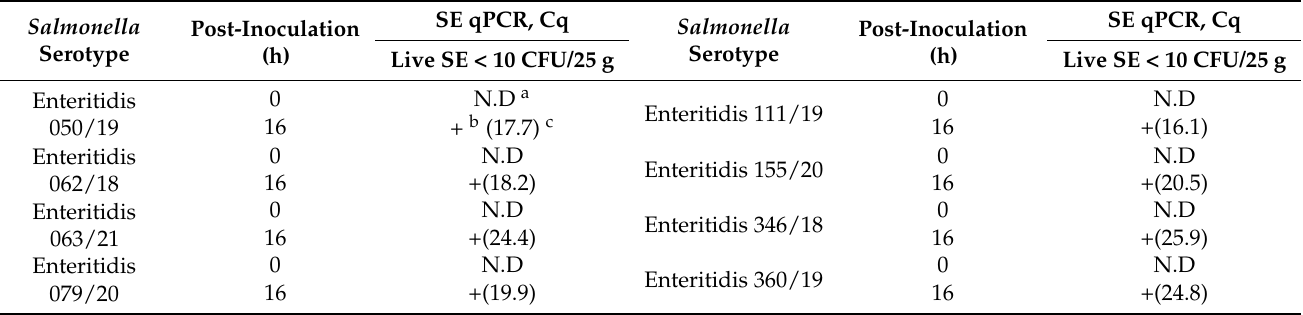
Table 3. Detection of live SE in artificially contaminated egg samples.